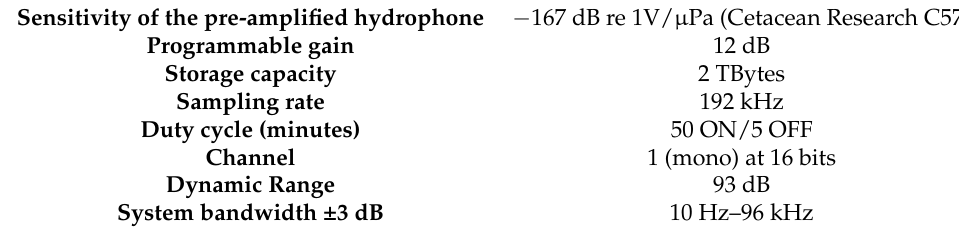
Table 1. PAM recording device